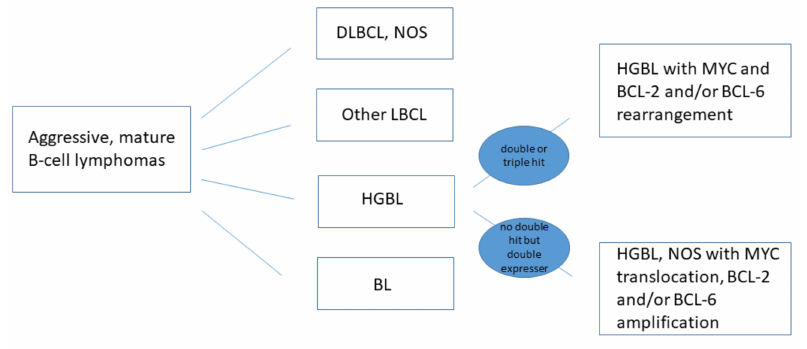
Figure 1. New WHO classification of HGB lymphomas